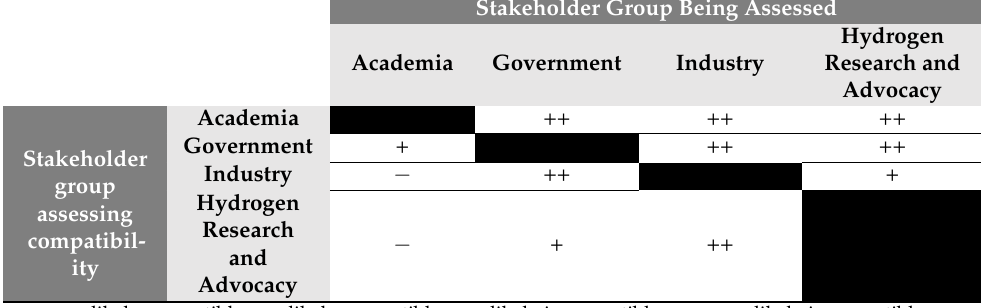
Table 5. Stakeholder group compatibility